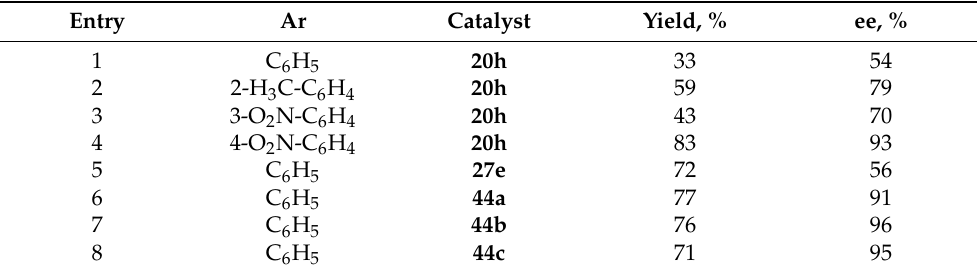
Table 9. Effect of crown ethers in the MIRC reaction of arylidene indane-1,3-diones ( 69 ) and diethyl bromomalonate ( 63 ).